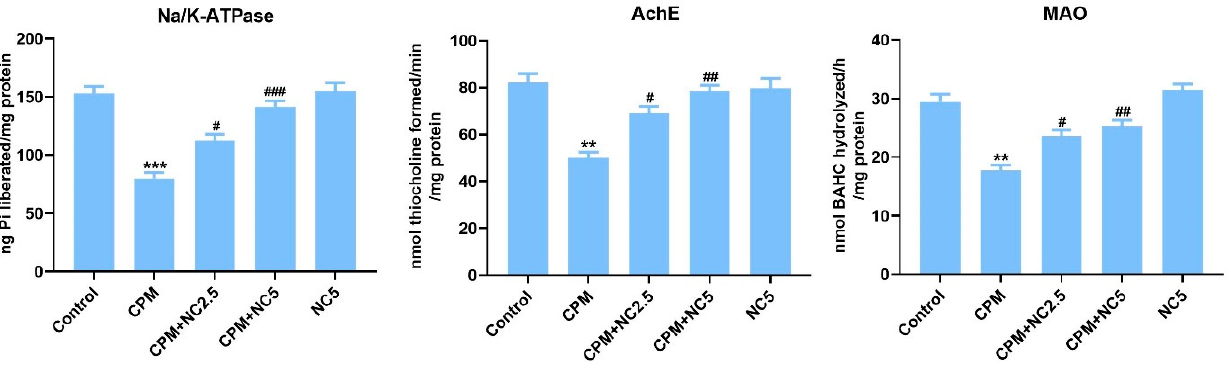
Figure 1. Effect of NC administration on neurotoxicity biomarkers (Na/K ATPase, AchE and MAO) against CPM-induced neurotoxicity. Data stated as mean ± SE (n = 6). ** p < 0.01; *** p < 0.01 vs.